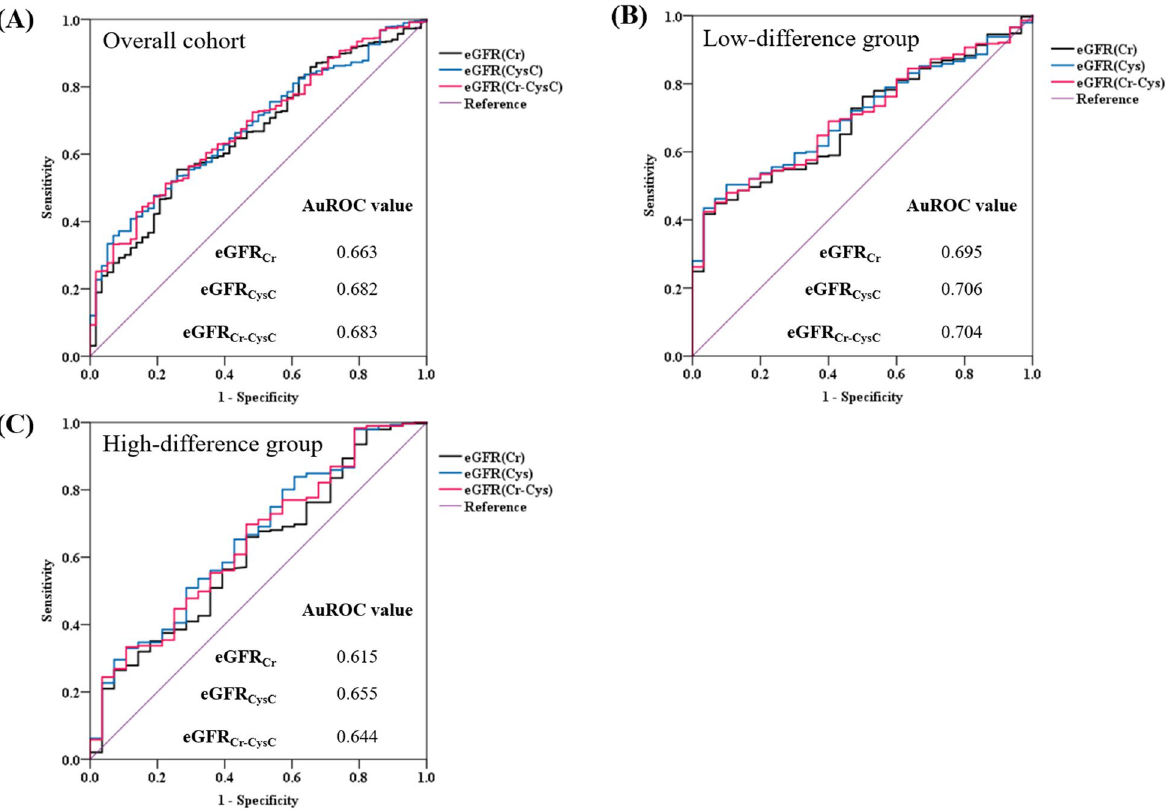
Figure 3. ROC curves and AuROC values of each eGFR equation for hyperphosphatemia. Panels ( A ), ( B ), and ( C ) show the ROC curves for each eGFR equation for the overall cohort, low-difference group, and high- difference group. The AuROC values of the eGFR equations are noted in each panel. AuROC, area under the ROC curve; eGFR, estimated glomerular filtration rate; eGFR Cr , eGFR based on creatinine; eGFR CysC , eGFR based on cystatin C; eGFR Cr-CysC , eGFR based on both creatinine and cystatin C; ROC, receiver operating